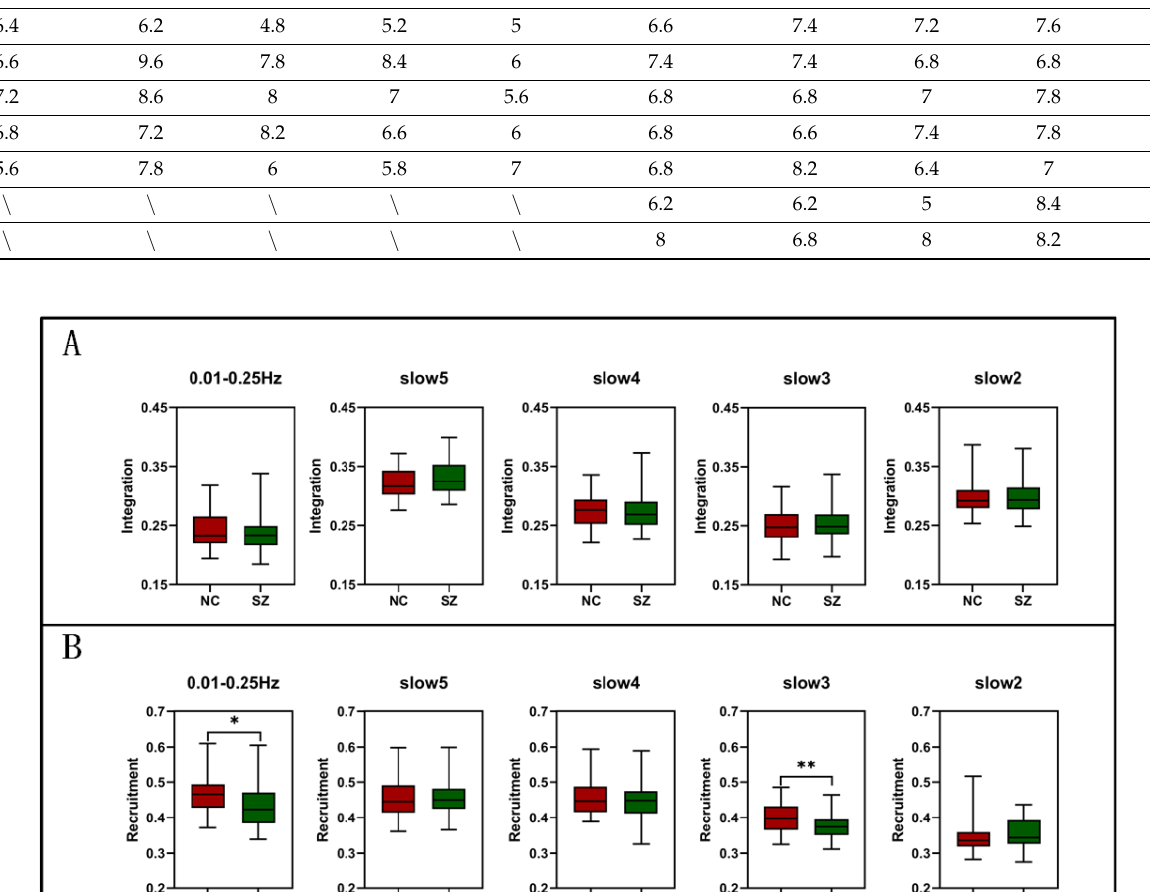
Figure 2. The difference of recruitment and integration from full frequency (0.01–0.25 Hz), slow5 (0.01–0.027 Hz), slow4 (0.027–0.073 Hz), slow3 (0.073–0.198 Hz), and slow2 (0.198–0.25 Hz) in the whole brain level between NC and SZ. ( A ) Integration. ( B ) Recruitment. Asterisk indicates pairwise group differences; * represents p < 0.05; ** represents p < 0.01.